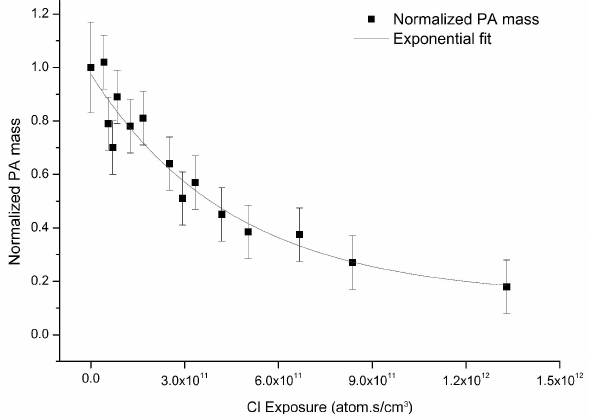
Figure 4. Mass-weighted particle distribution (normalized µg m -3 ) of PA particles before 11 Fig. 4. Mass-weighted particle distribution (normalized µgm − 3 ) of (filled squares) and after (open squares) a chlorine exposure of 1.25x10 11 atom cm -3 s. Each 12 PA particles before (filled squares) and after (open squares) a chlo- distribution is an average of eight measurements. 13 rine exposure of 1 . 25 × 10 11 atomcm − 3 s. Each distribution is an average of eight measurements. Evidence of presence of monochlorinated palmitic acid is found in the mass spectra. 15 Fragments with m/z=362 and 364 are detected and correspond to the parent peaks of the 16